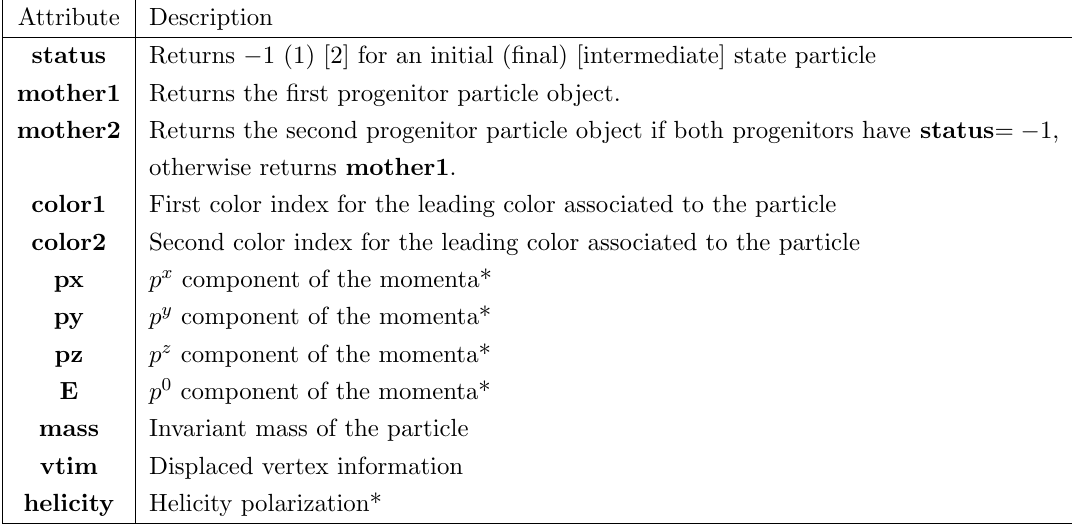
Table 9. List of common Les Houches event (cid:12)le attributes available to the Re-Weighting module; see ref. [90] for further details. * denotes that the quantity is de(cid:12)ned in the lab frame by